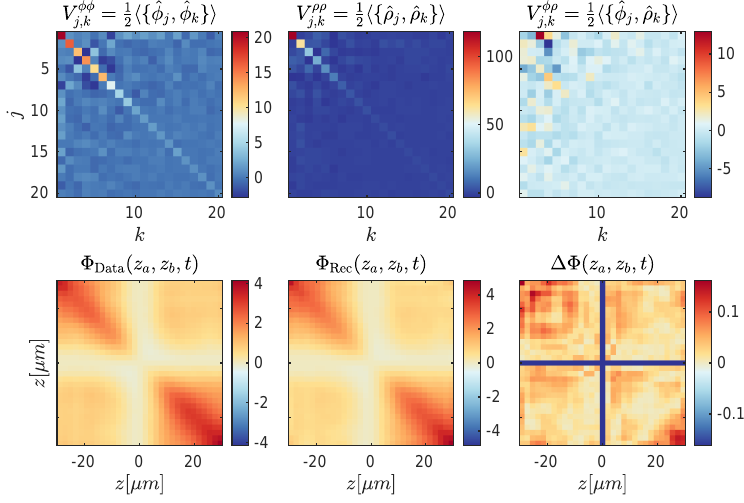
Figure 21: A reconstruction for the same experimental scan as in Fig. 8 but now = 20. Comparing with the earlier allowing for an larger number of eigen-modes N = 10 eigen-modes we find a rather good convergence in reconstruction using N the sense that the correlations which are well-resolved in space and time (modes with k ≤ 7) are accurately reproduced in both reconstructions. It should be stressed that the time step of the measurements and the spatial resolution of the read- out camera do not allow the accurate resolution of higher momentum modes, and the reconstruction favors diagonal non-squeezed correlations in these modes. The inclusion of additional modes softens the hard cut-off at high momentum modes leading to less off-diagonal artifacts.